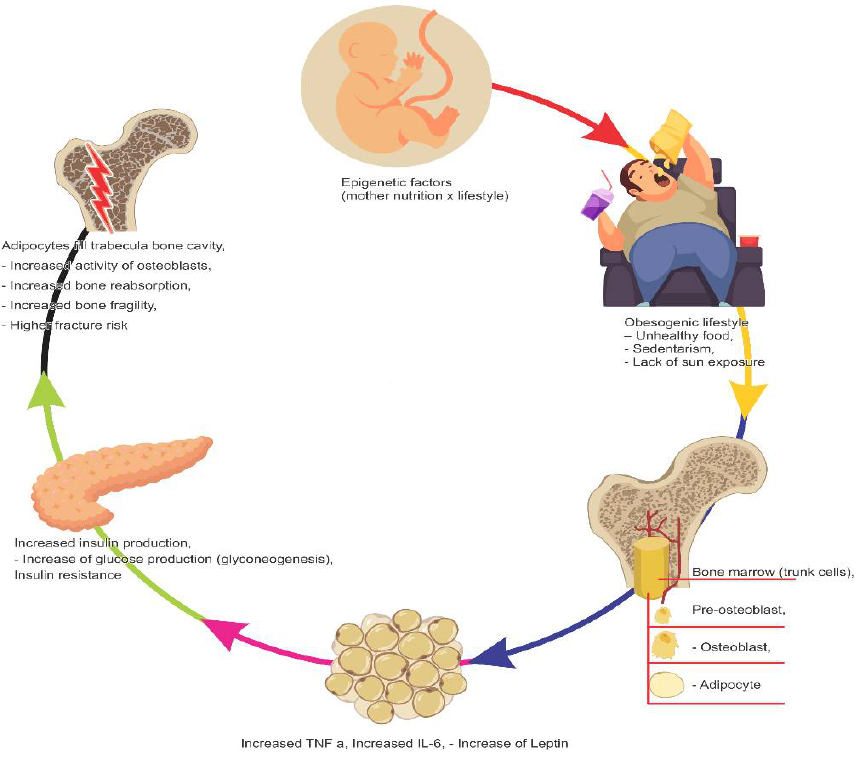
Figure 1. Factors that impair bone health.